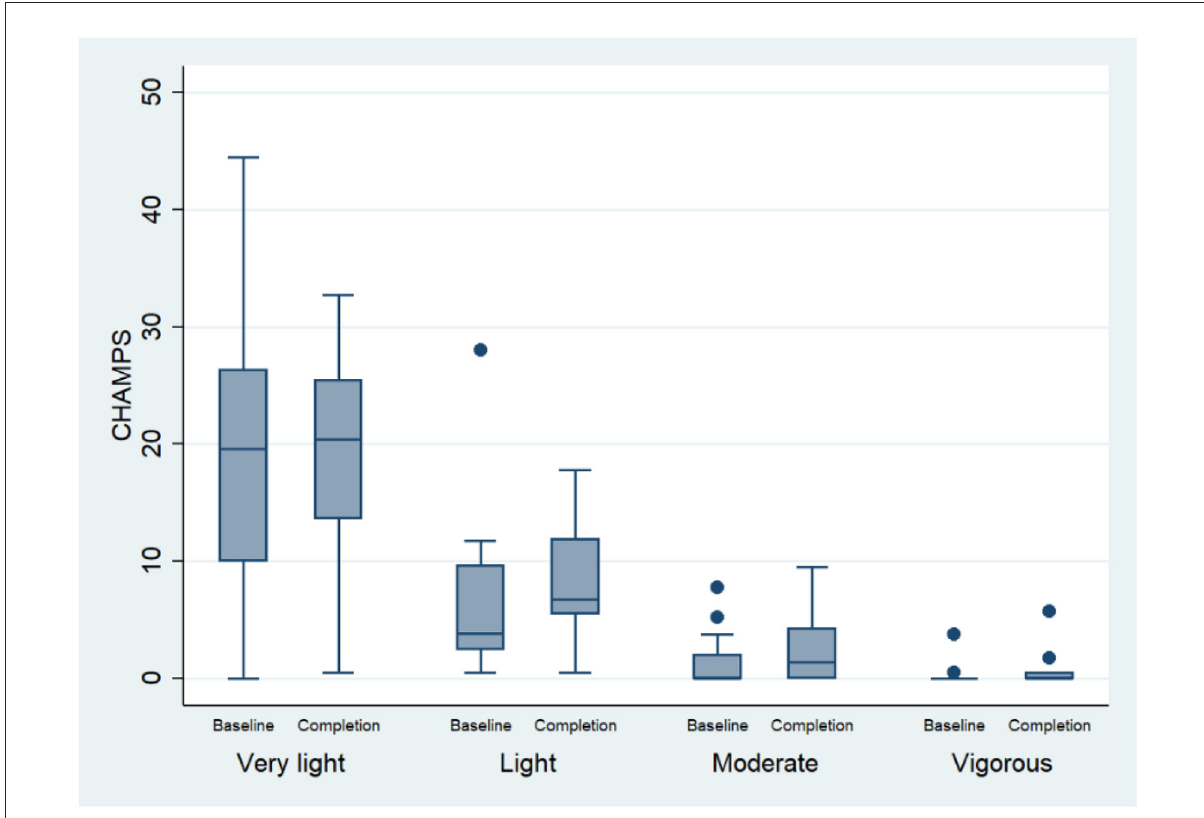
FIGURE1 Change in physical activity performance (measured using the CHAMPS) between baseline and follow-up.